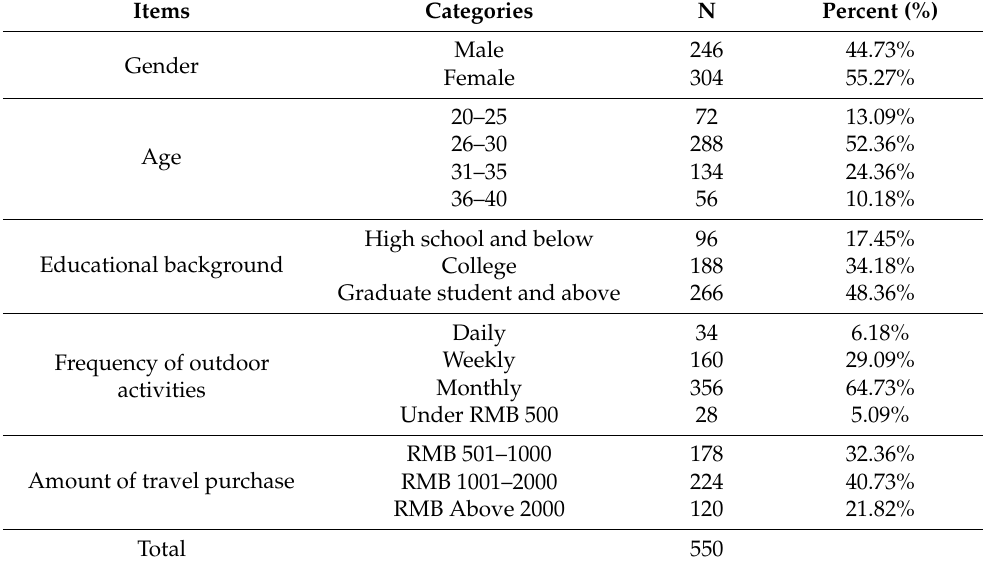
Table 2. Demographic description.